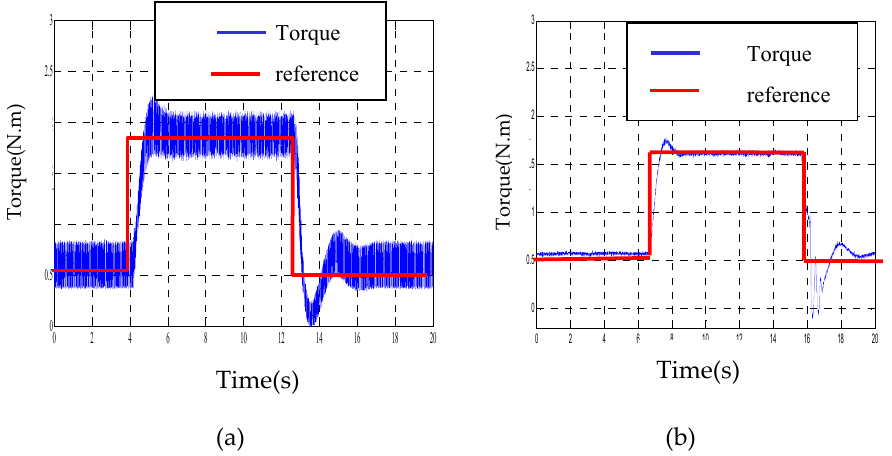
Figure 14. C omparison between ( a ) 2L_FOC and ( b ) 3L_FOC in open and closed loop Figure 14. Comparison between ( a ) 2L_FOC and ( b ) 3L_FOC in open and closed loop conditions in conditions in terms of Torque ripple. terms of Torque